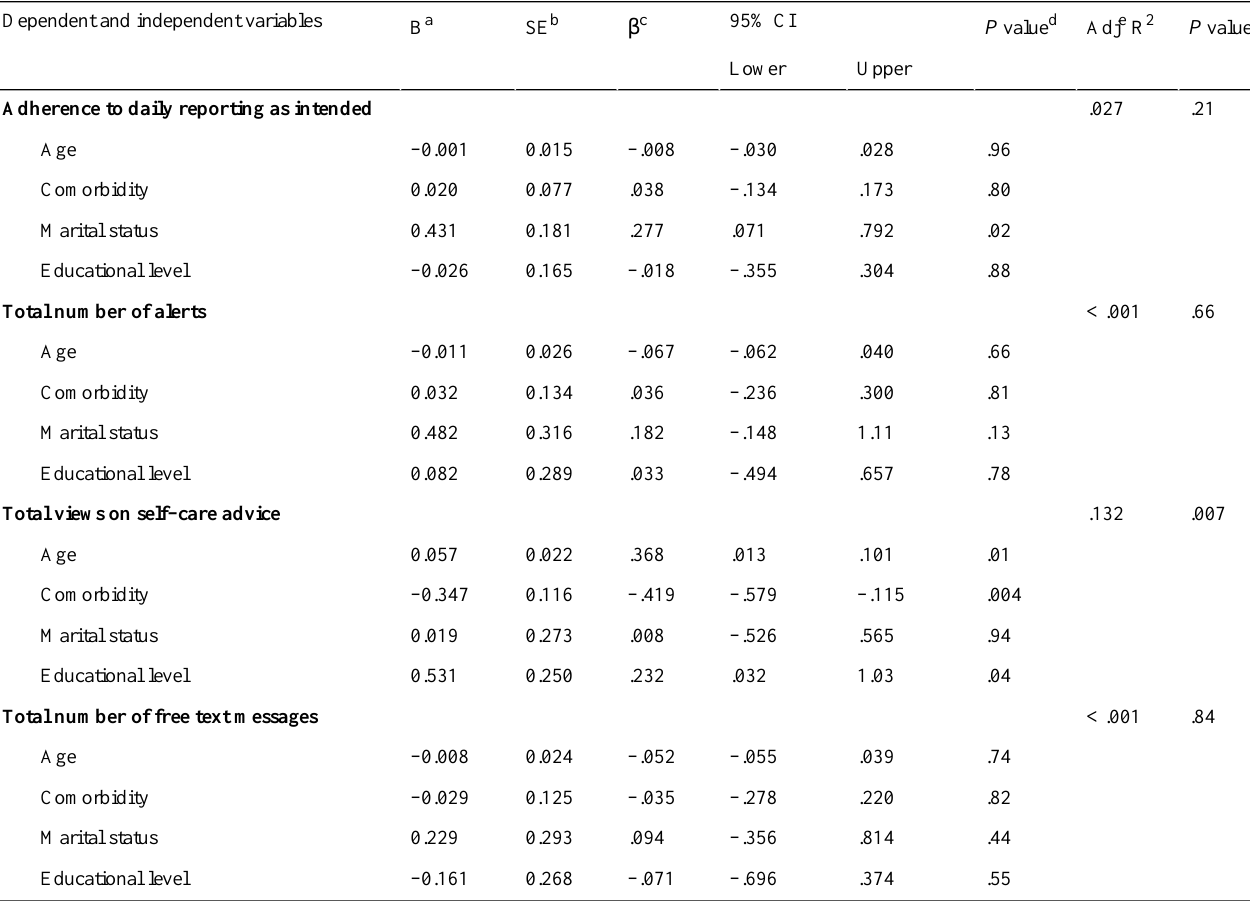
Table 5. Multiple Regression in patients with prostate cancer